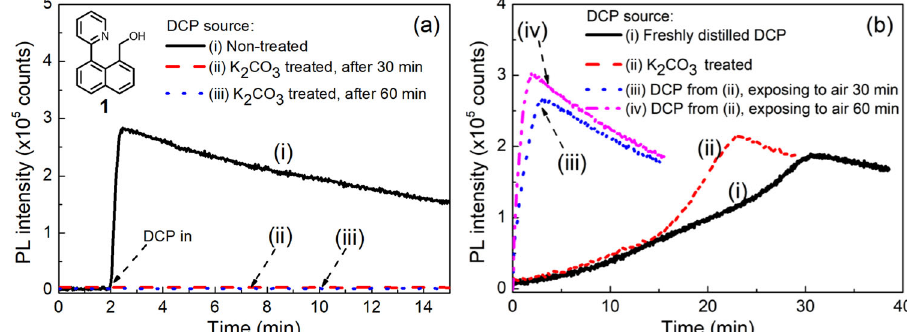
Fig. 6 Sensing results of compound 1 upon exposure to differently treated DCP. Representative PL kinetics curves for 10 wt% 1 :cellulose acetate sensing fi lms under ( a ) a nitrogen fl ow containing non-treated DCP or potassium carbonate-treated DCP (30 or 60 minutes), and ( b ) an air atmosphere with freshly distilled DCP (curve i), potassium carbonate-treated DCP (curve ii), and potassium carbonate-treated DCP left in air for 30 (curve iii) and 60 min (curve iv). The PL kinetics were recorded using an OceanOptics Flame spectrometer.